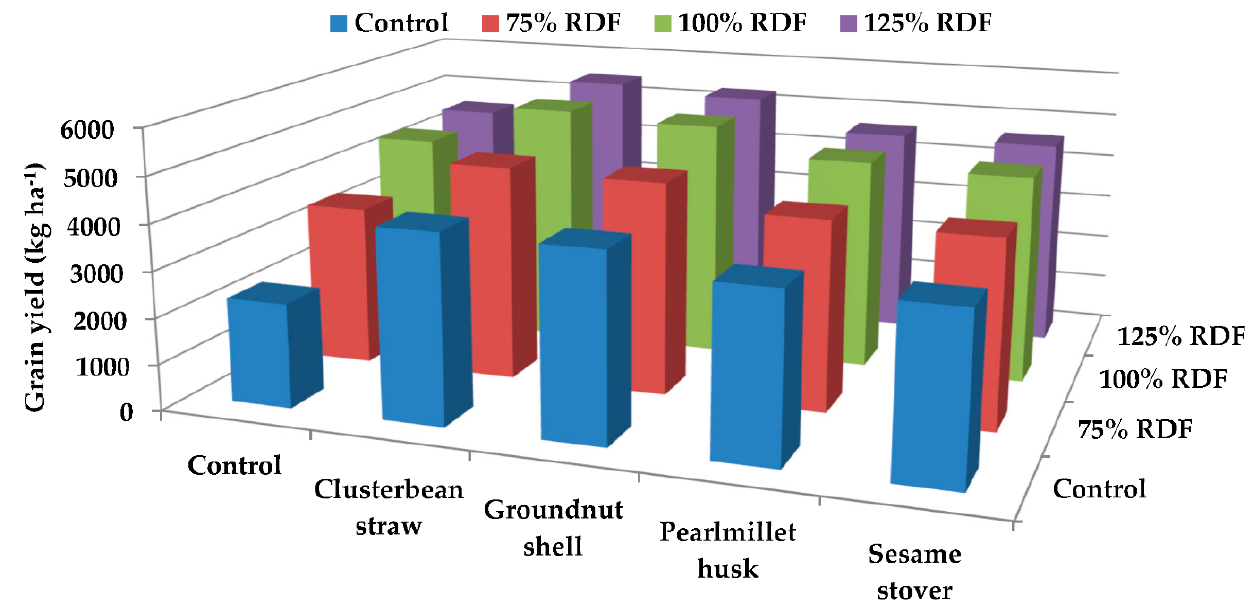
Agronomy 2022 , 12 , x FOR PEER REVIEW Figure 4. Interaction effect of crop residues and fertilization on grain yield of wheat.